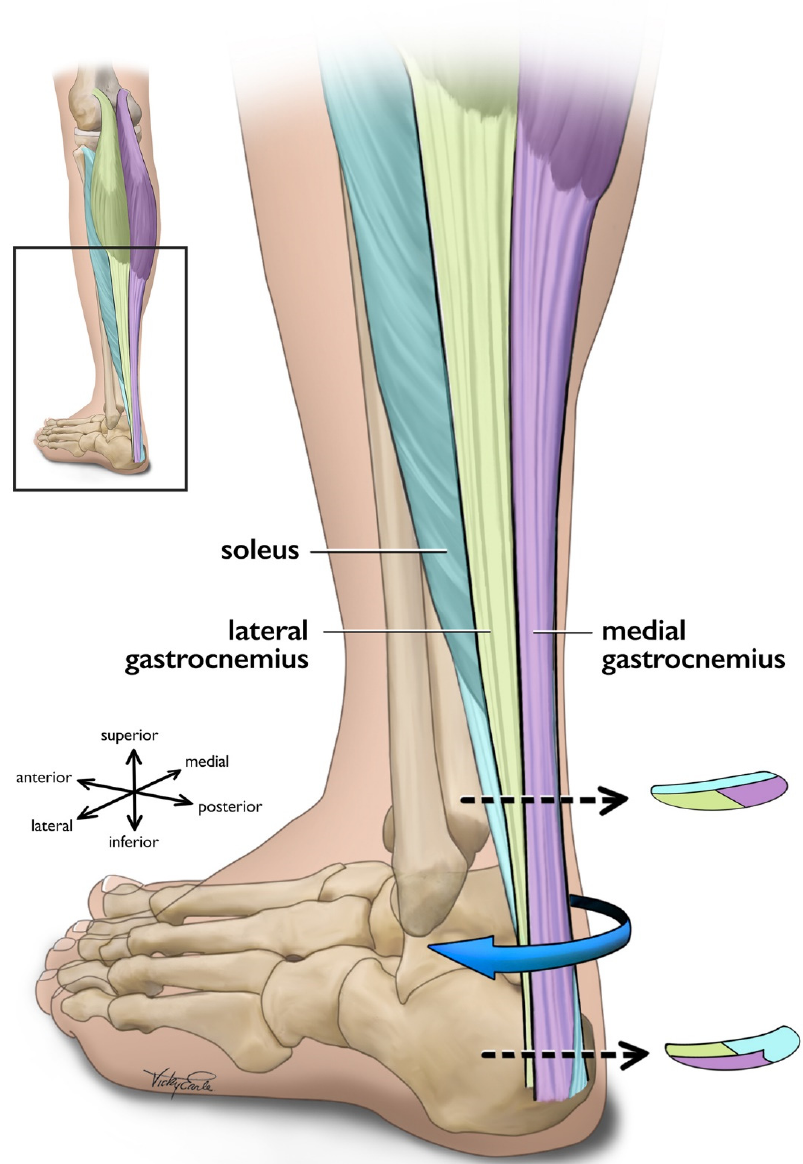
Figure 1. Posterolateral view of the left Achilles tendon and the three subtendons which comprise it. Subtendons rotate in a clockwise fashion traveling distally down the tendon. Cross-sectional views are displayed near the proximal and distal ends of the free tendon, and are based on cadaveric studies [56,82]. The soleus and soleus subtendon are colored teal, the lateral gastrocnemius and associated subtendon chartreuse, and the medial gastroc and its subtendon